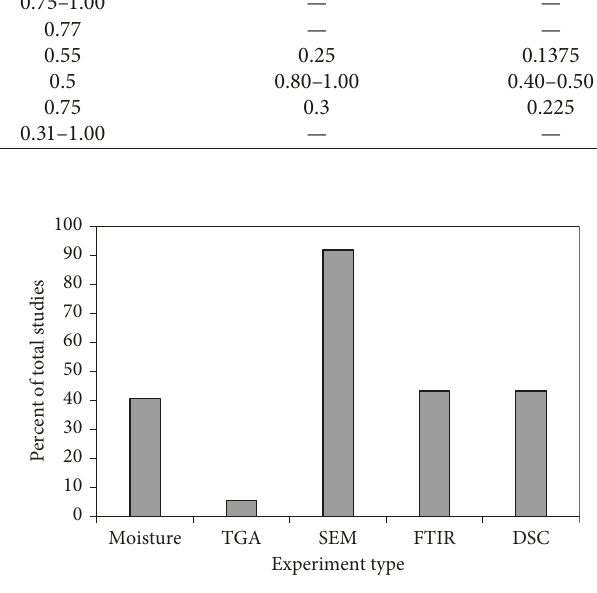
Figure 7: Percentage distribution of microstructure tests across investigated past research.